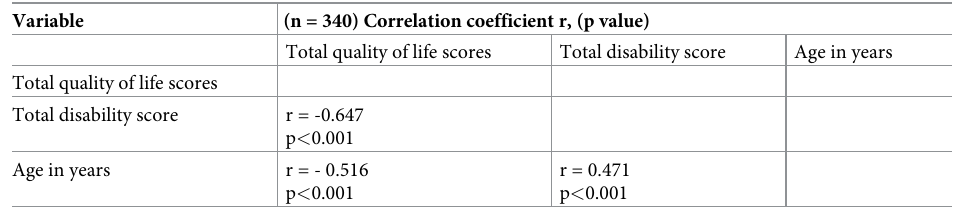
Table 4. Correlation matrix for persons with onchocerciasis.